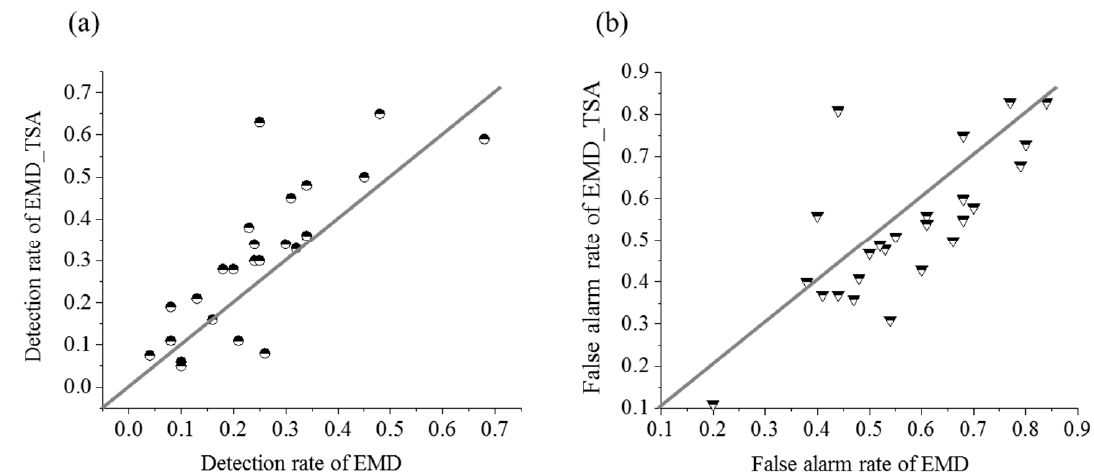
Figure 8. Scatterplot for the performance of EMD_TSA versus EMD. Each dot represents results from a video of STNS datasets. The diagonal line displays the locus of equal value. ( a ) The detection rate for EMD_TSA versus EMD. ( b ) The false alarm rate for EMD_TSA versus EMD. Finally, we validated the performance of EMD_TSA by comparing its performance with DSTMD [16] (directionally selective small target motion detectors. Available: https:// github.com/wanghongxin/DSTMD, accessed on 7 October 2022) and STMD plus model [26] (Available: https://github.com/wanghongxin/STMD-Plus, accessed on 8 October 2022) in the STNS and RIST dataset. The comparison results are shown in Figure 9. As is shown in Figure 9a, most dots ( t -test, p < 0.05) were below the diagonal line indicating that the detection rates of the EMD_TSA were slightly higher than that of the DSTMD and STMD plus model. In Figure 9a, most dots ( t -test, p < 0.05) appeared in the above diagonal, indicating the false alarm rates of EMD_TSA are less than that of the other two models in both databases. In summary, these results show that EMD_TSA obtains the better performance for real videos, which means that the EMD_TSA can work more stably for different cluttered backgrounds and target